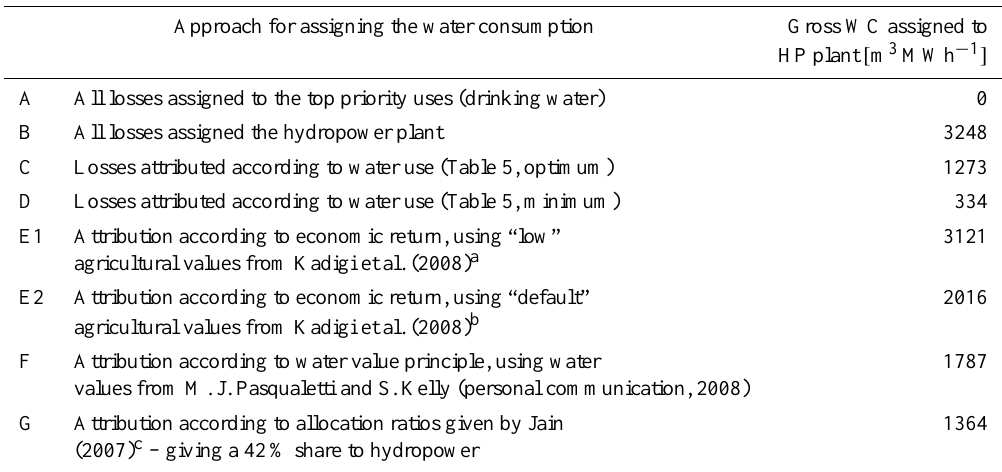
Table 6. Calculated water consumption values for the hydropower plant in the multi-purpose SRPS with various models for attributing water losses to the hydropower